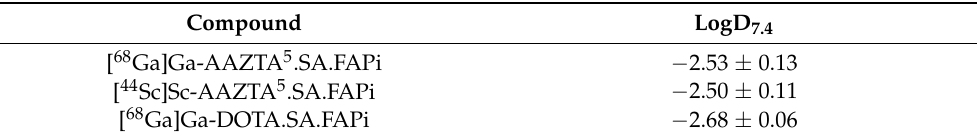
Table 2. LogD values (pH = 7.4) of [ 68 Ga]Ga-AAZTA 5 .SA.FAPi, [ 44 Sc]Sc-AAZTA 5 .SA.FAPi and [ 68